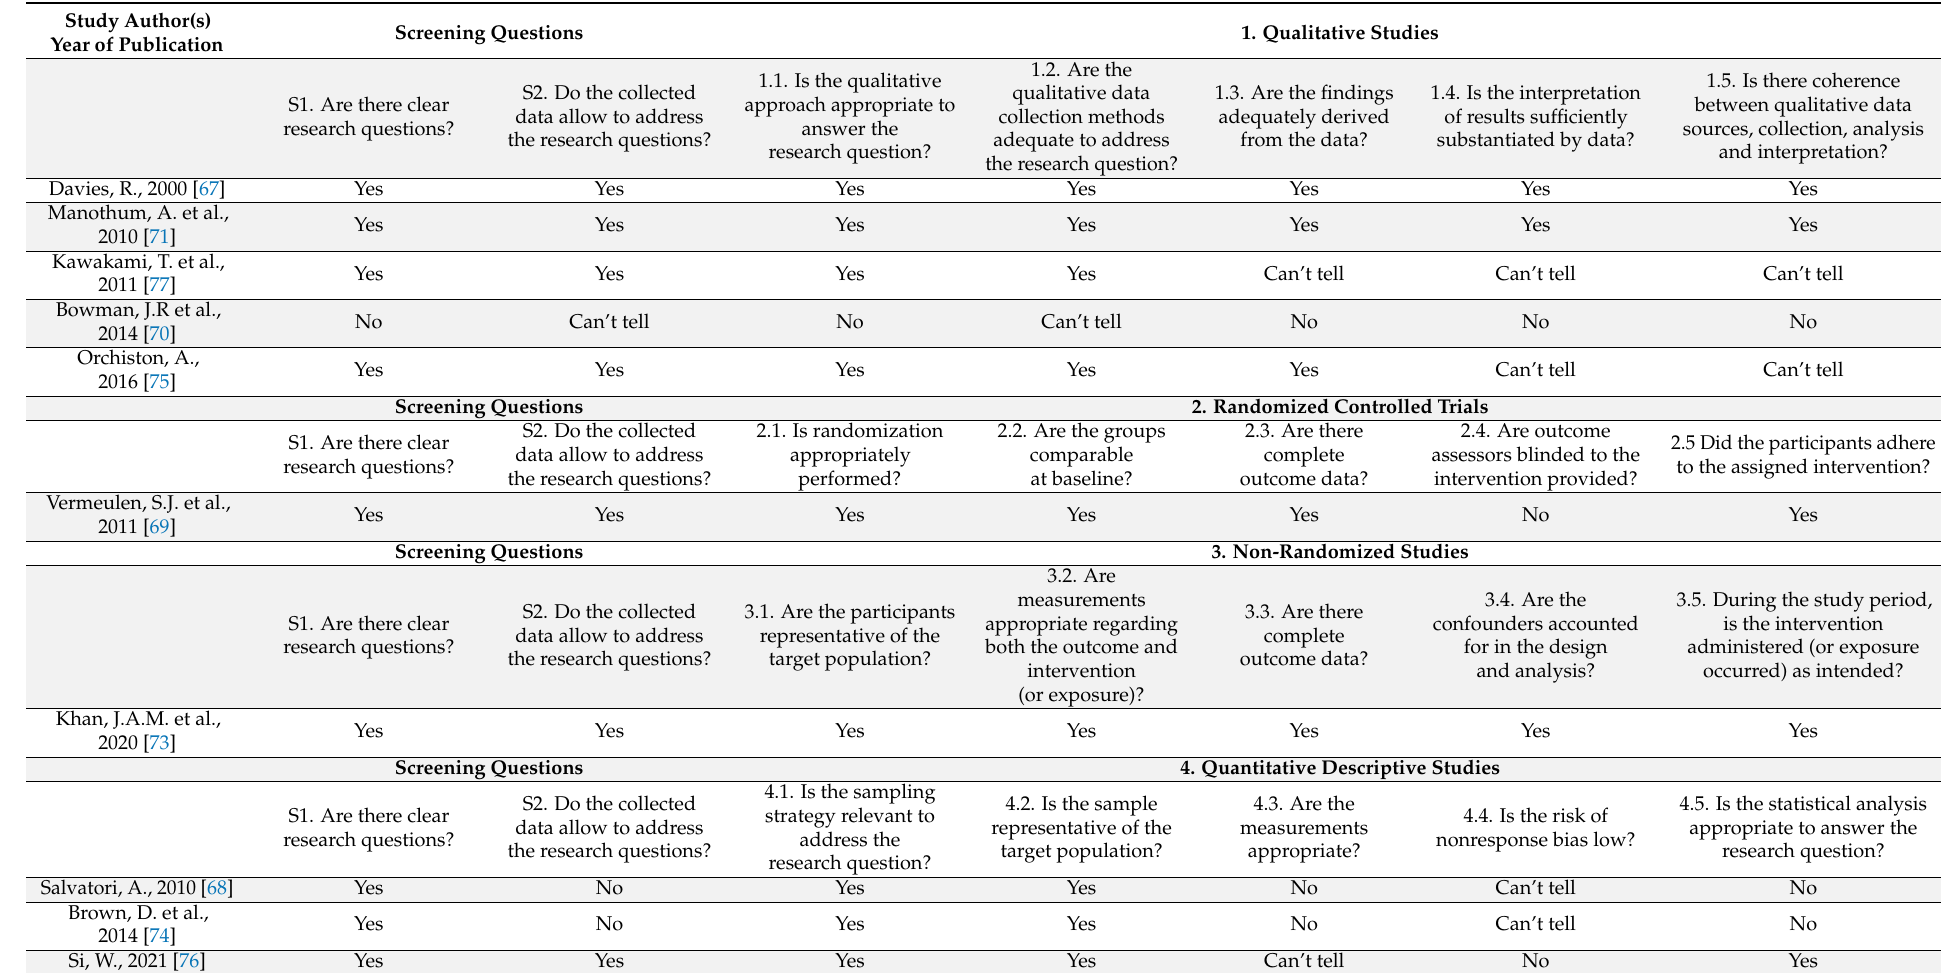
Table 6. Risk of bias assessment of included studies using the Mixed Methods Appraisal Tool